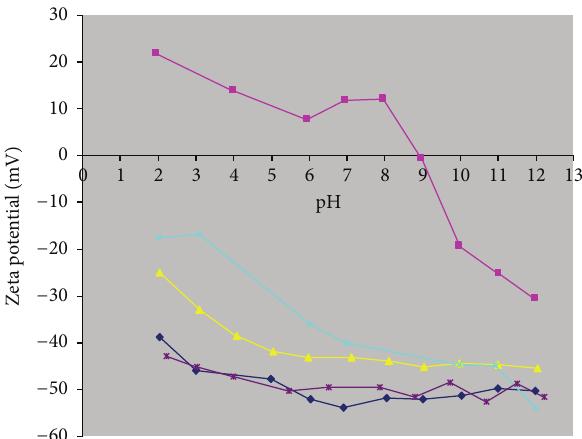
with HNO 3 ( Q ); 3N + 1S (X); KMnO 4 ( 󳵳 ); NaOCl ( ∗ ), under various